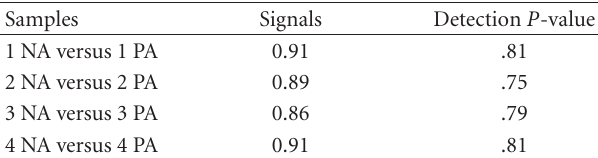
Table 1: Pearson correlations of microarray signals and detection P -values between non amplified (NA) and amplified (PA) RNA samples from four colorectal carcinoma specimens. The RNA was isolated from identical samples and underwent either amplification or no amplification prior to microarray